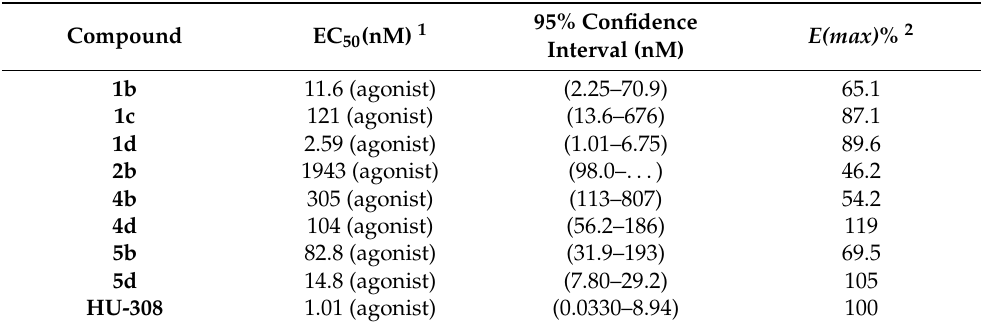
(Table 2) (Figure 5). Compound 2b with a hexyl side chain in C5 (cid:48) instead of C4 (cid:48) weakly stimulated the [ 35 S]GTP γ S binding to hCB2R. Table 2. Functional potencies (EC 50 ) of key fenchone derivatives and HU-308 for the hCB2R ( ± SE confidence limits).